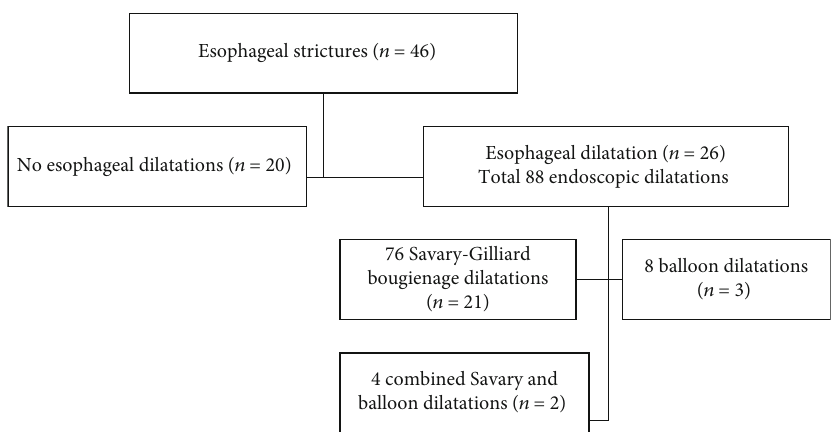
Figure 1: Endoscopic esophageal dilatations performed in children with esophageal